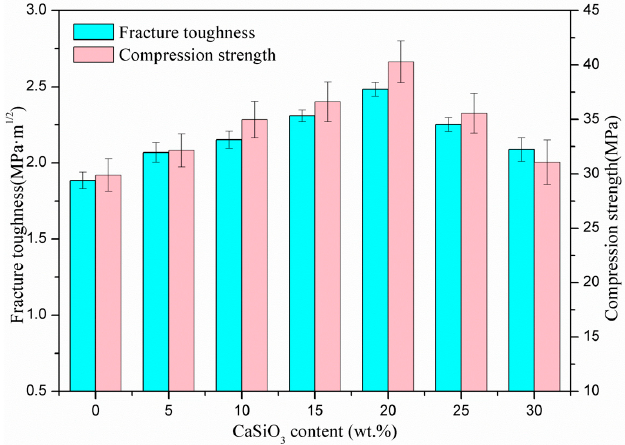
Figure 2. Fracture toughness and compression strength of the scaffolds with different CaSiO 3 content.